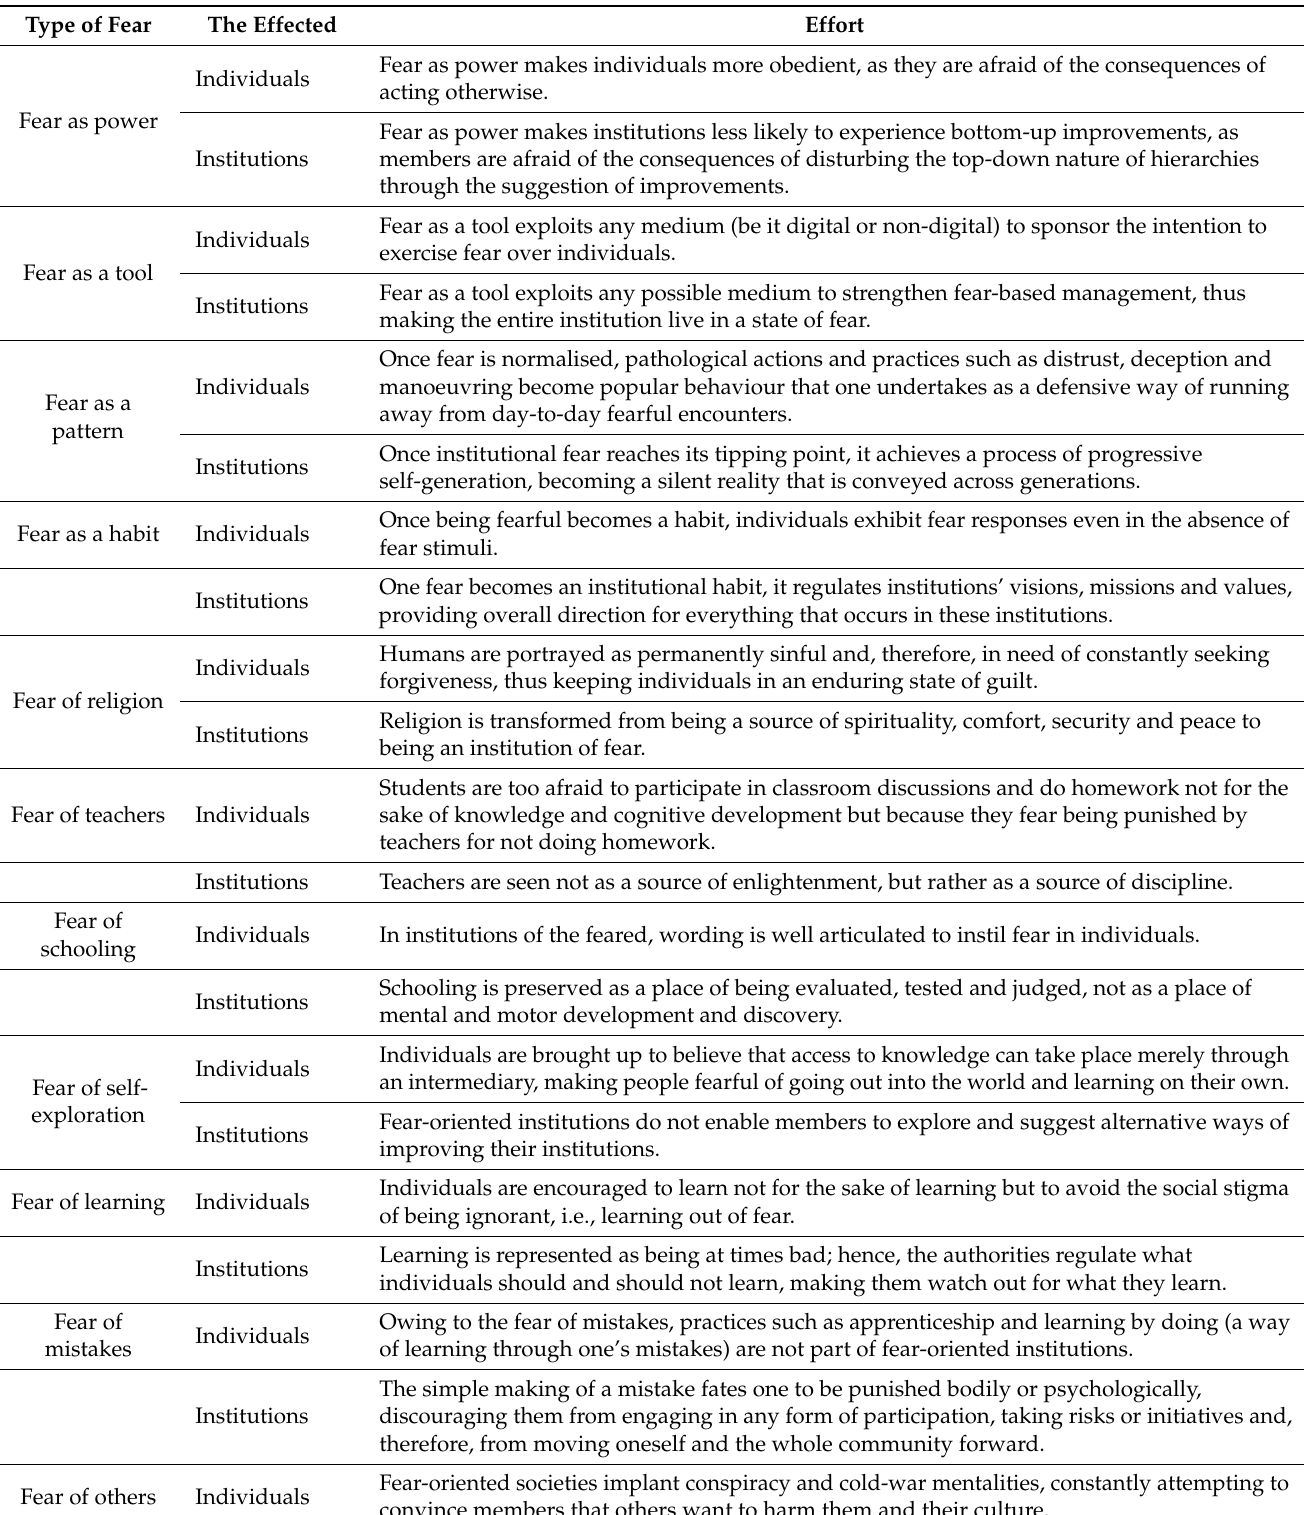
Table 1. The Effects of Fear on Individuals and